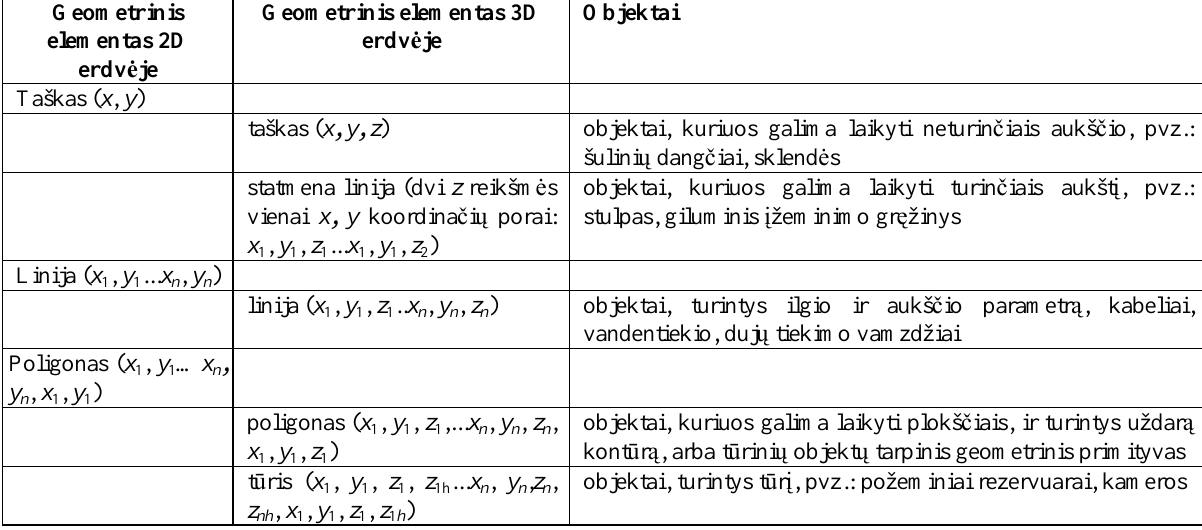
Table 2. Transformation cases for geometrical primitives of underground